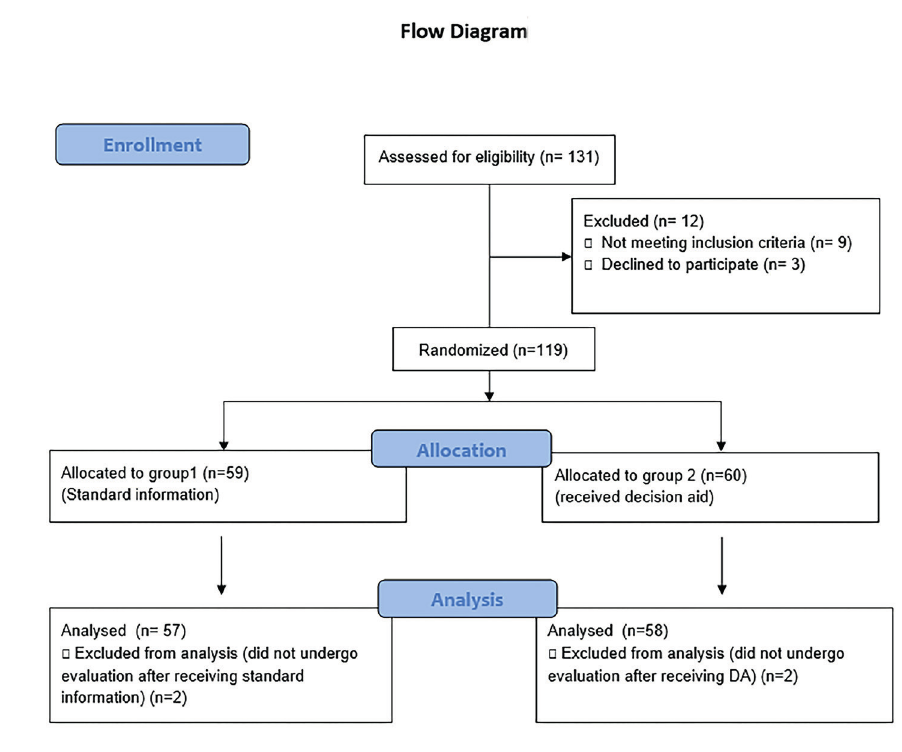
Figure 1 - Flow diagram for enrollment of the patients to the